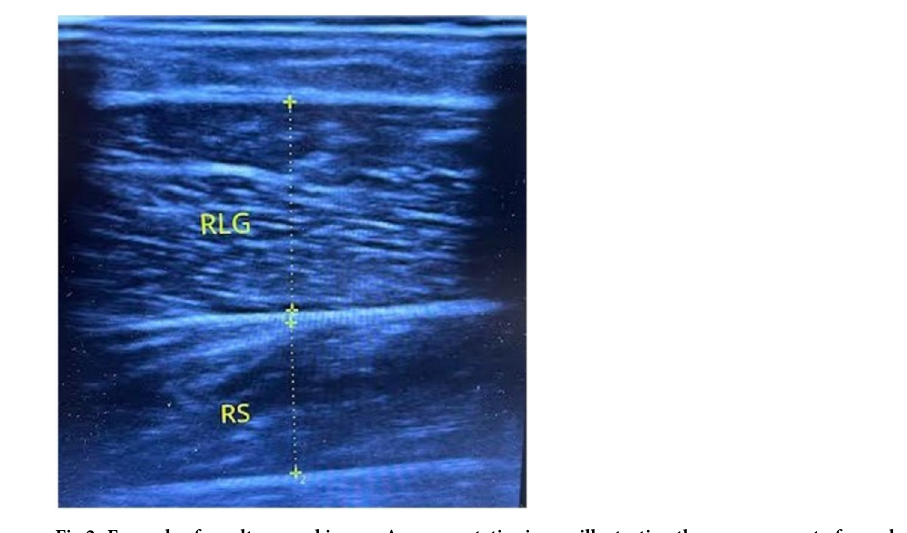
Fig 2. Example of an ultrasound image: A representative image illustrating the measurement of muscle